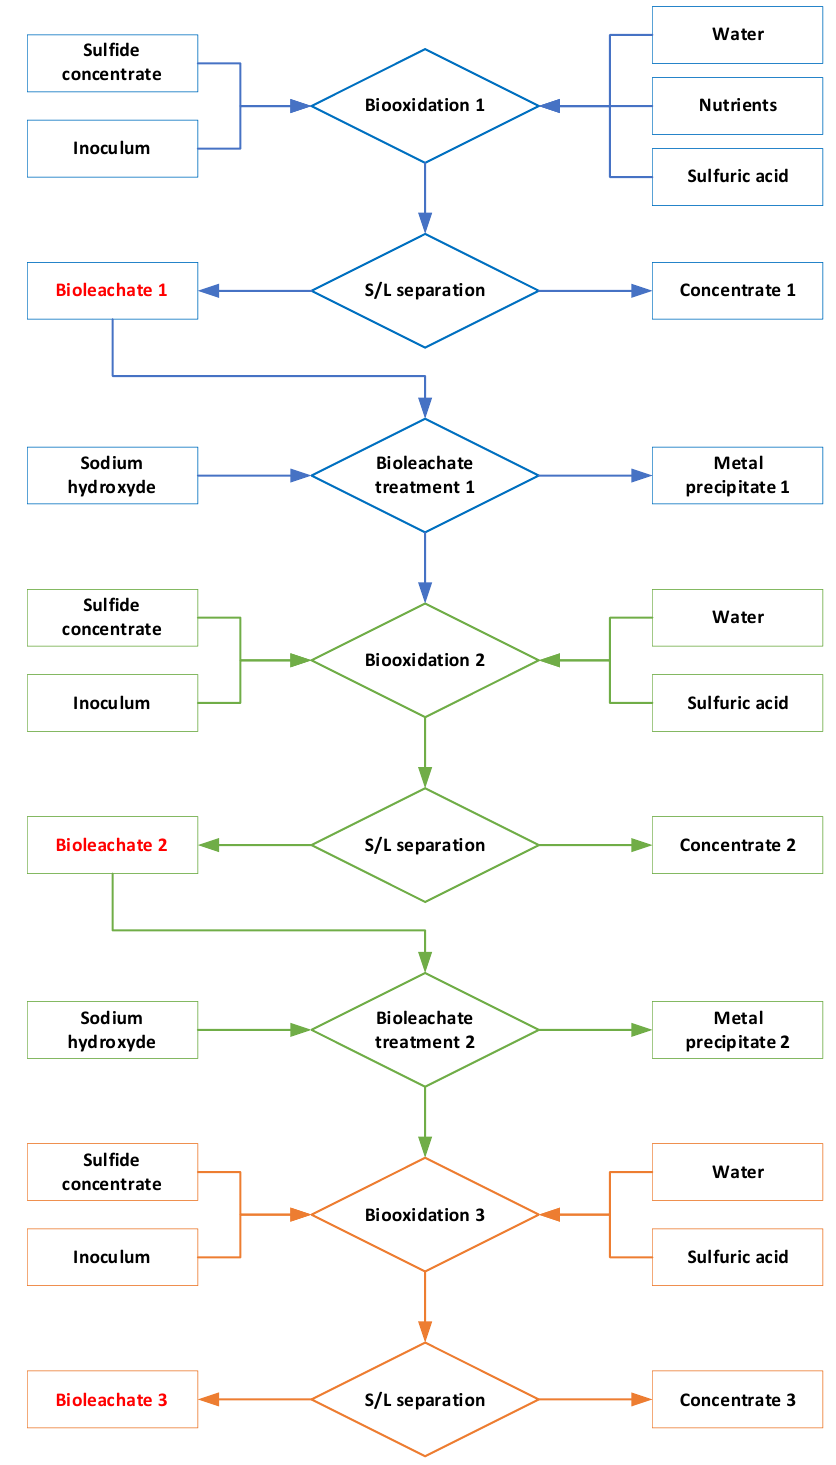
Figure 1. Flowsheet of the reuse of bioleachate in the biooxidation process.